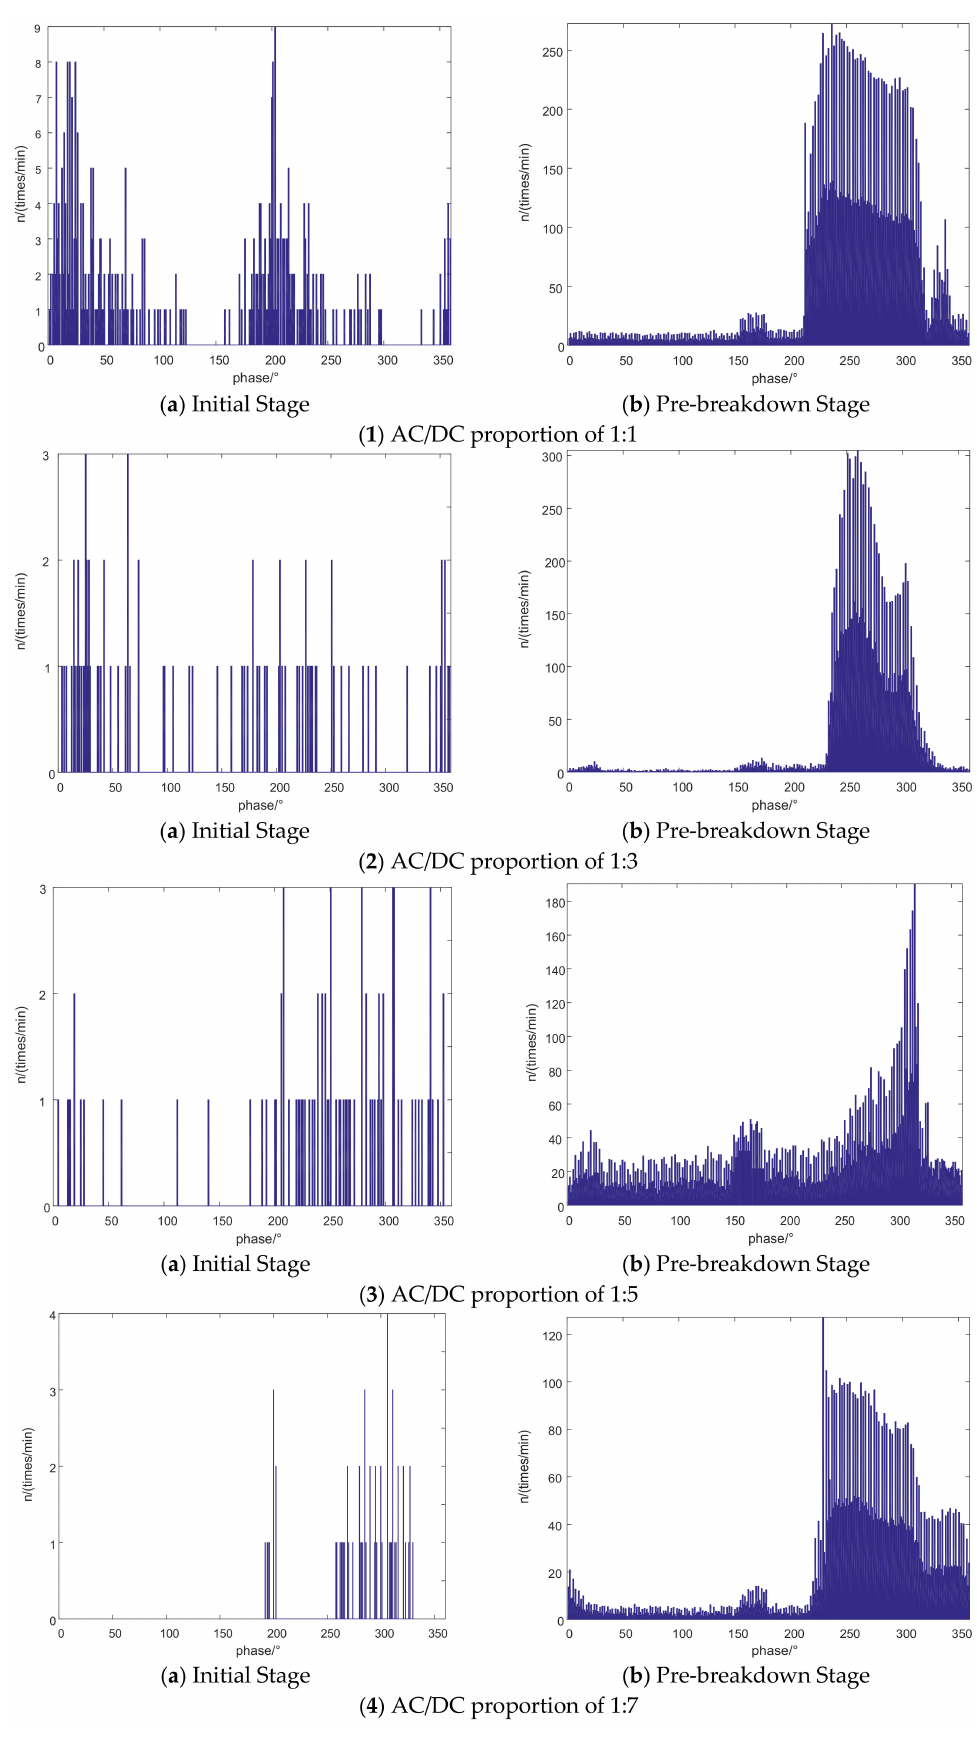
Figure 18. Phase distributions of PD pulses under different AC/DC